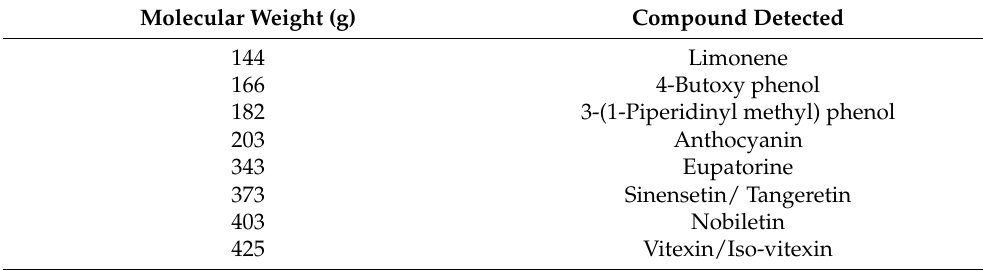
Figure 1. Characterization of Citrus nobilis peel extract using ( a ) FTIR spectra; ( b ) LCMS chromatogram. Table 1. Identification of compounds present in modified solvent evaporated extract of Citrus nobilis peel.